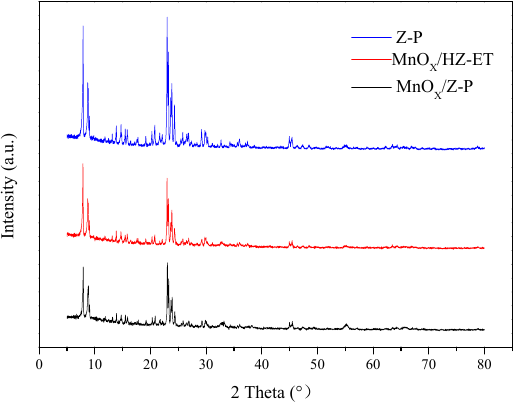
Figure 1. XRD patterns of the catalysts. Table 1. Relative crystallinity (RC) of the catalysts.